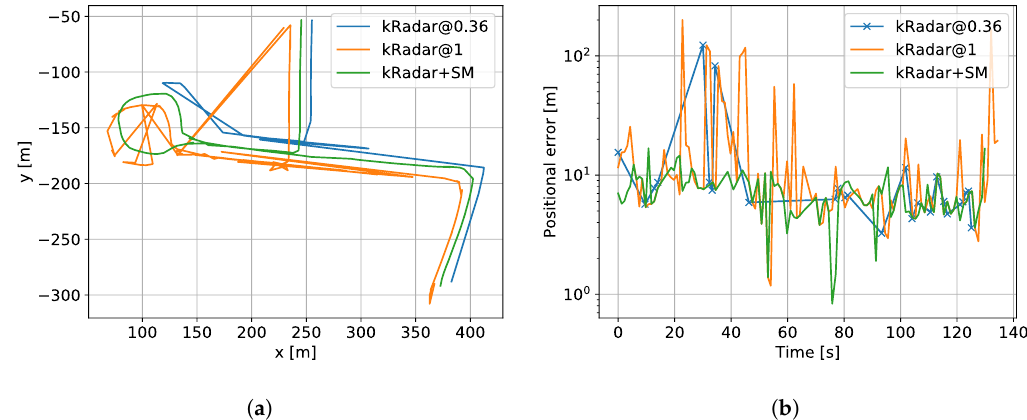
Figure 10. ( a ) Qualitative view of the localisation process. The tracks have been offset for visualisation purposes. ( b ) Positional errors as the localised trajectory one single trial. kRadar@0.36 has been labelled with crosses due to its low recall. Please notice the logarithmic scale.